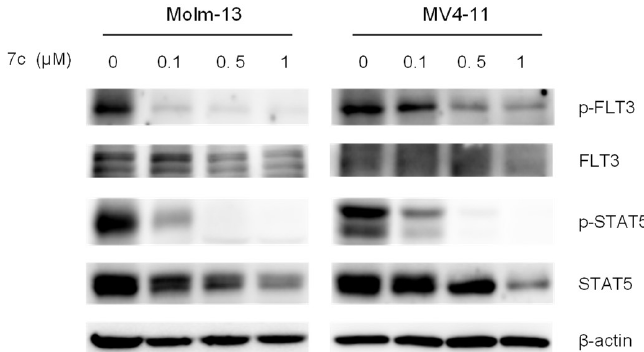
Figure 3. Compound 7c inhibited FMS-like tyrosine kinase 3 (FLT3) signaling. Human FLT3-internal tandem duplication-positive acute myeloid leukemia (FLT3-ITD + AML) cells (Molm-13 and MV4-11) were treated with 7c at the indicated concentrations for 48 h, and cell lysates were subjected to immunoblotting for detecting FLT3 and STAT5. β-actin was used as the loading control.